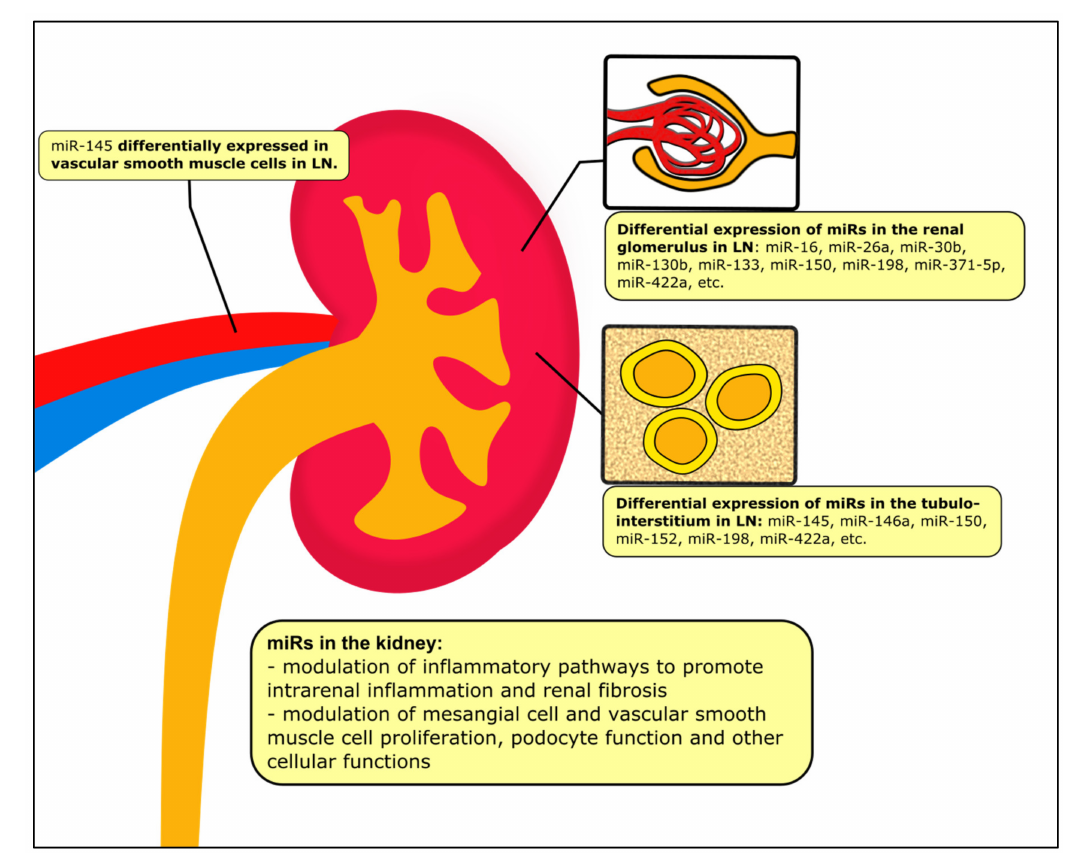
Figure 2. The role of miRs in different compartments of the kidney tissue in